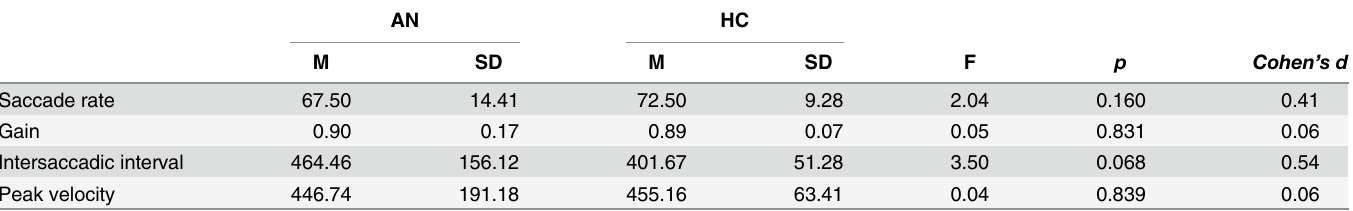
Table 2. Self-paced saccade task